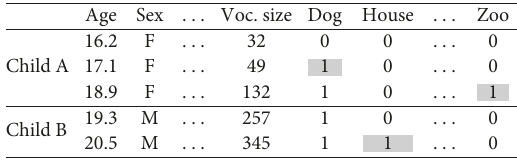
Figure 2: Example longitudinal CDI data for two children. Our models are trying to predict when a word enters the graph or the grey